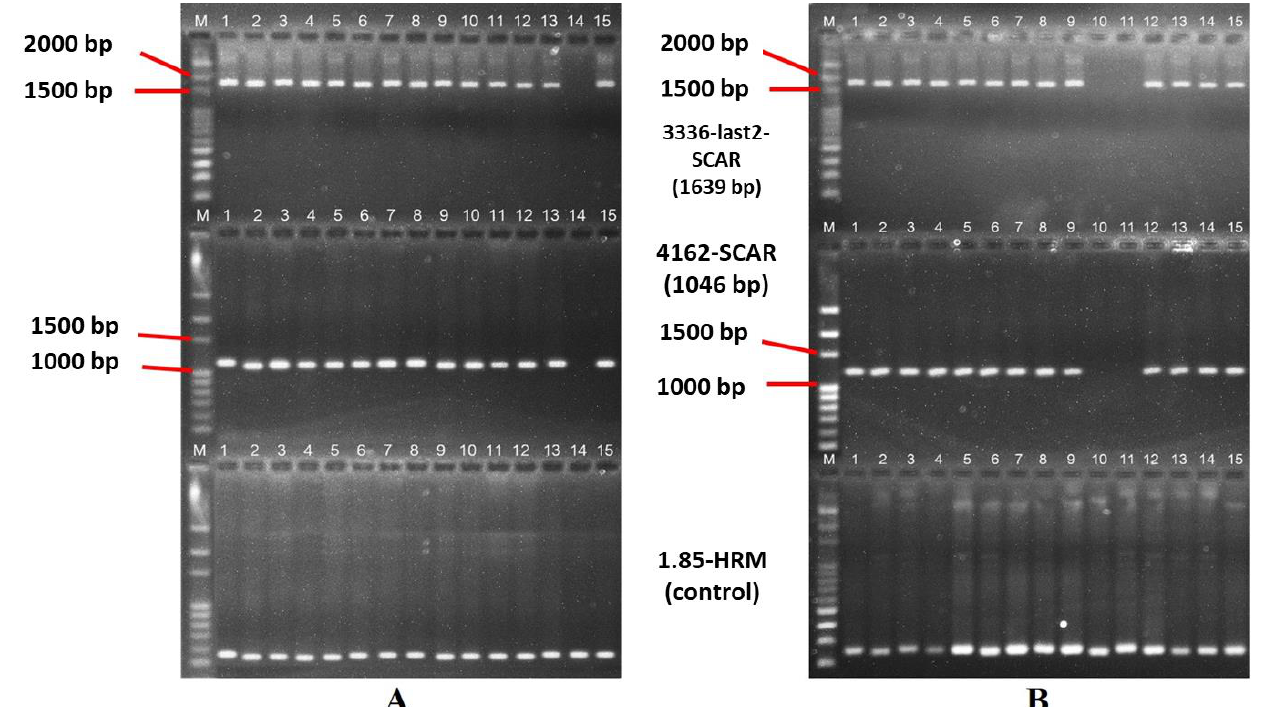
Figure 4. Amplification of 3336-last2-SCAR (top), 4162-SCAR (center), and 1.85 HRM (control) (bot- tom) in BC 1 F 2 progeny of B-line group for 15 plants (Lanes 1–15), BC 1 F 2 B1 × C1 ( A ), BC 1 F 2 B1 × C3 ( B ), and 100 bp DNA ladder (lane M).